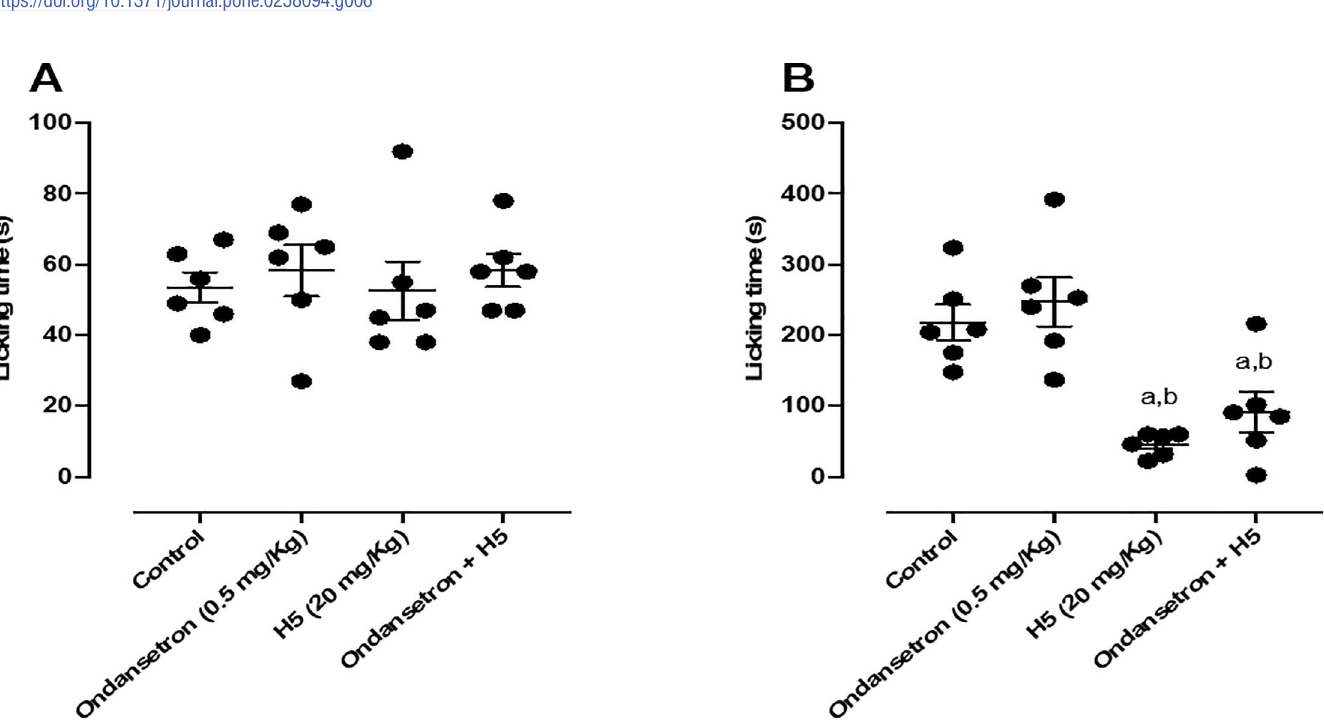
Fig 7. Effect of ondansetron (0.5 mg/kg, i.p.), H5 (20 mg/kg, p.o.), ondansetron + H5 in the first (A) and second (B) phases of the formalin-induced nociception test in mice (n = 6, per group). Values are expressed as the mean ± S.E.M., where a indicates p < 0.05 in comparison with control group and b indicates p < 0.05 in comparison with the ondansetron group, according to ANOVA, followed by Tukey’s post-test.